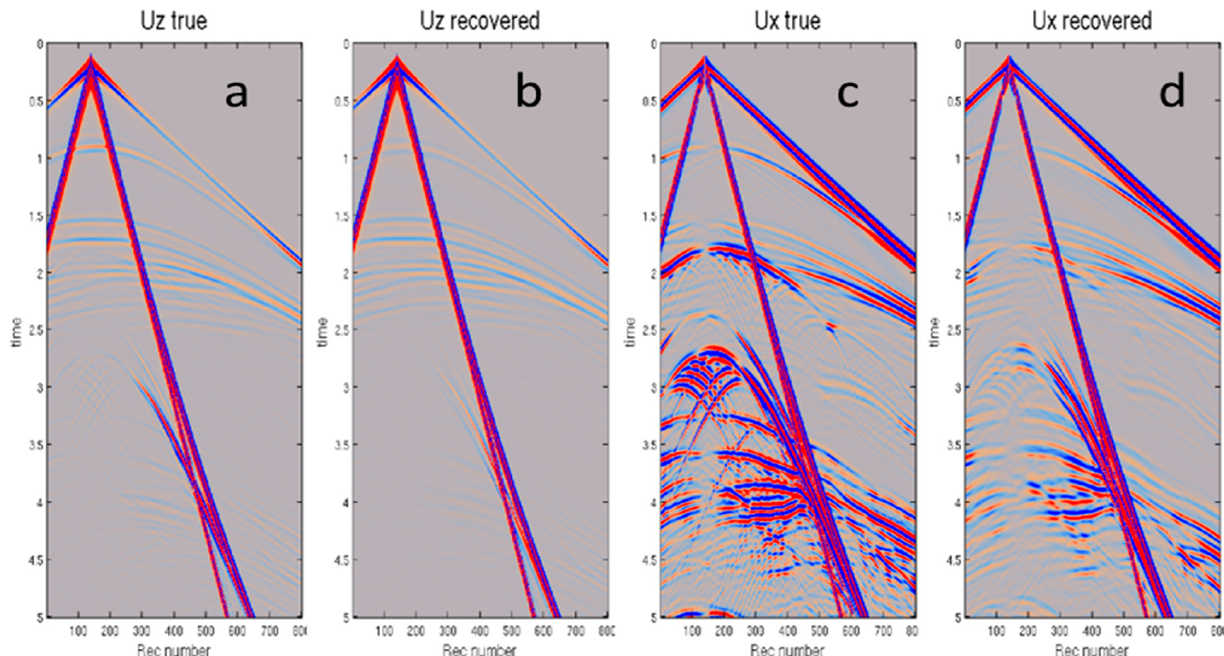
Figure 9. The seismogram calculated for source positioned at x = 700 m: U z components computed using the original Gullfax velocities ( a ) and the inverted DSR FWI model ( b ); ( c , d ) are U x components for the real and inverted wave propagation velocities respectively.